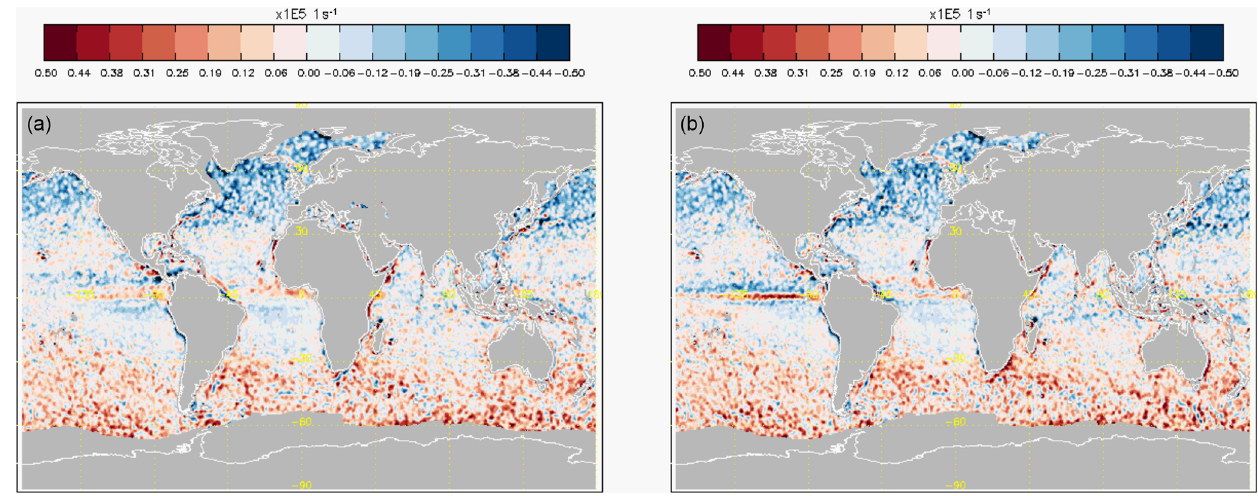
Figure 15. Global maps of annual difference in mean wind curl between ASCAT and ERA5 before (a) and after (b) the ocean current correction.